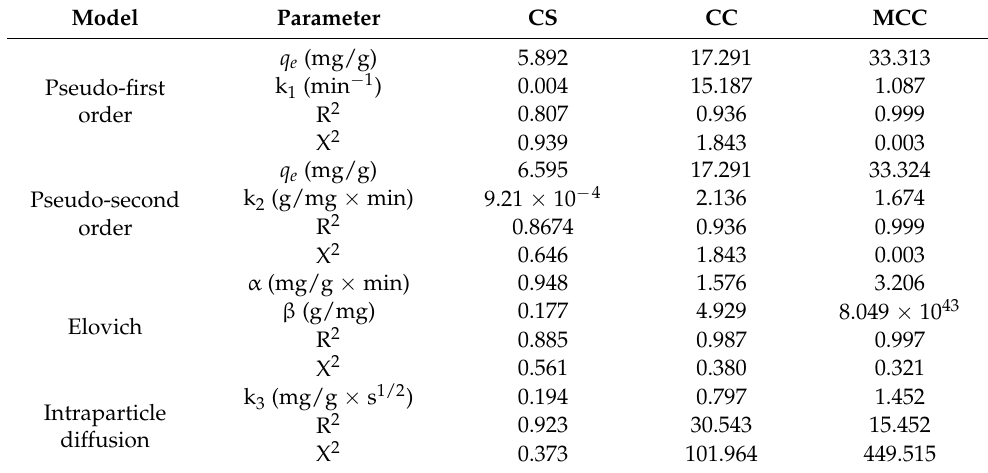
Table 4. Adjustment parameters of Congo red adsorption on bioadsorbents from coconut